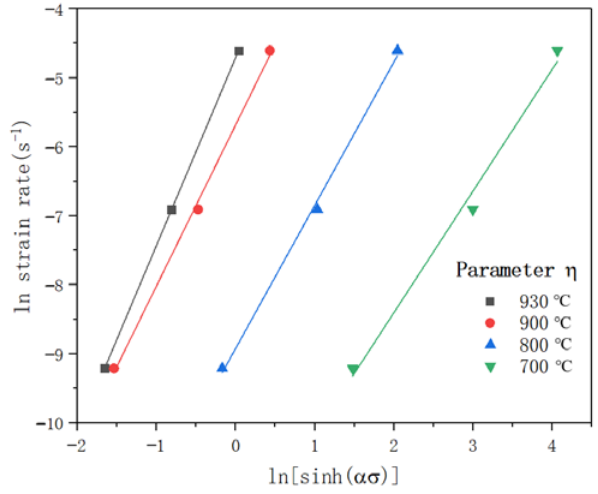
. ε and ln [ sinh ( ασ )] . and 𝑙𝑙𝑛𝑛𝜀𝜀̇ 𝑙𝑙𝑛𝑛 [sinh ( 𝛼𝛼𝜎𝜎 )]